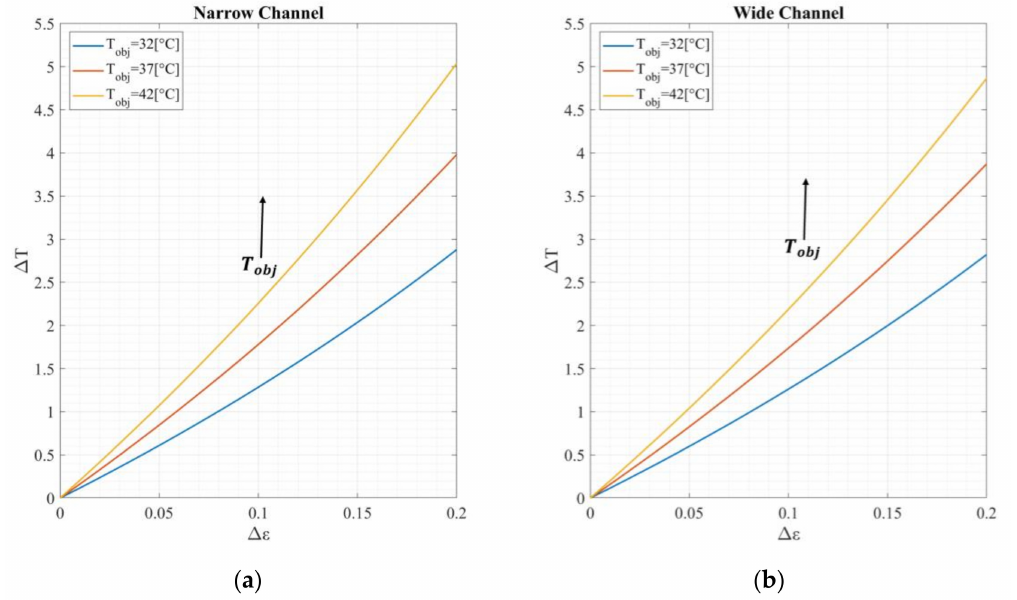
Figure A2. The temperature inaccuracy induced by emissivity inaccuracy up to 0.2 ◦ C at an assumed ambient temperature of 20 ◦ C for the two channels under study: ( a ) narrow bandpass 8–14 µ m; ( b ) wide bandpass 5.5–13.5 µ m.